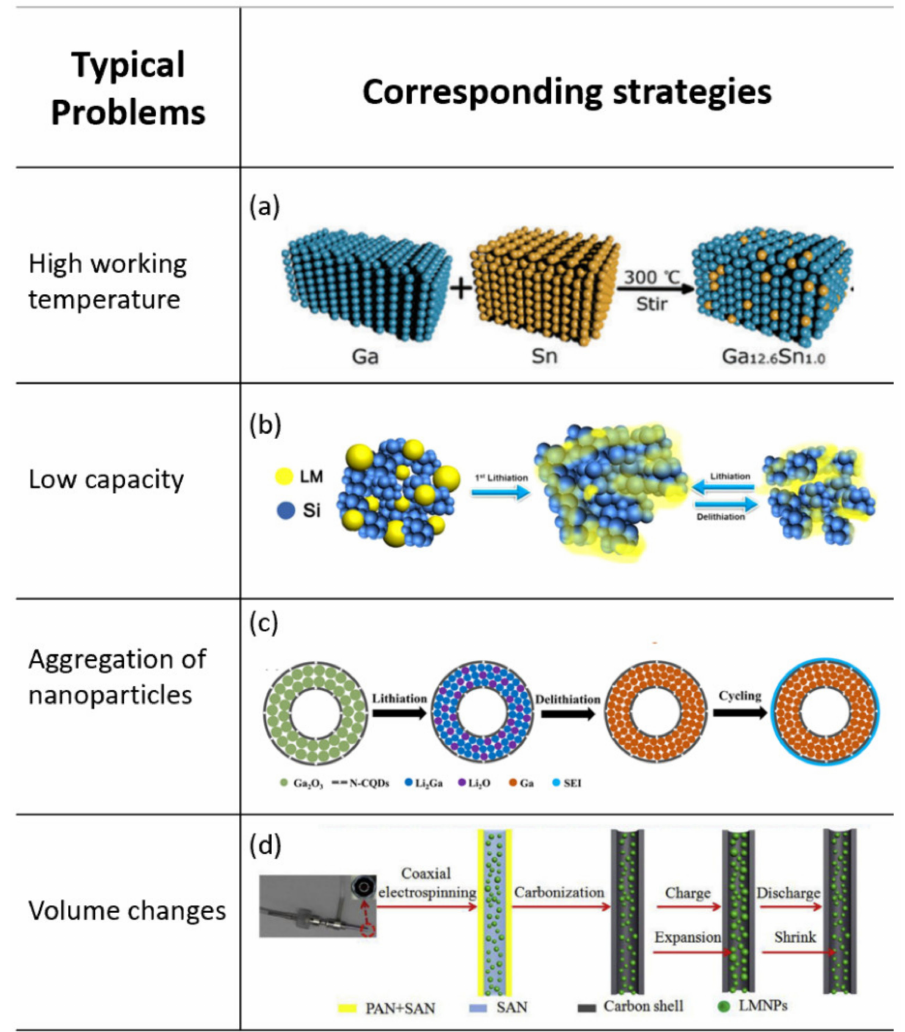
Figure 3. Typical problems and strategies for Ga-based self-healing electrodes. ( a ) synthesis